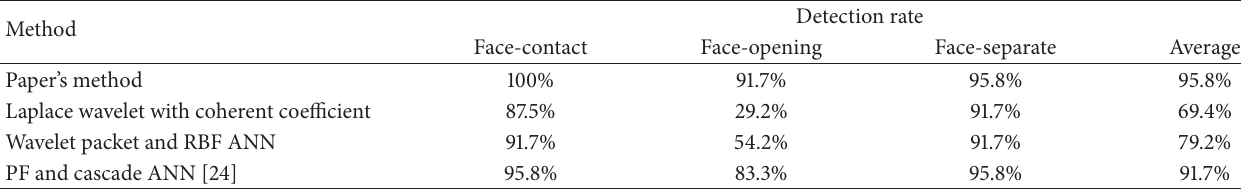
Table 4: The detection